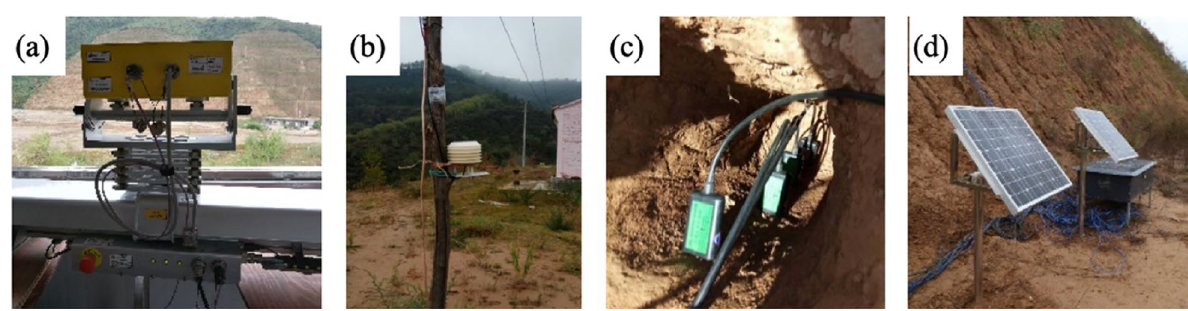
Figure 2. ( a ) GB-SAR instrument facing the slope. ( b ) Weather station for collecting meteorological data, installed on a pole approximately 2 m from the GB-SAR instrument and 1.5 m above the ground surface. ( c ) Hygrothermograph for collecting soil temperature and moisture data at four depths (0.1, 0.25, 0.4, and 0.6 m into the slope), installed at sites 1 and 2 (Fig. 1). The photo was taken prior to inserting the sensors into the slope. ( d ) Solar panels and the box containing the data acquisition system.